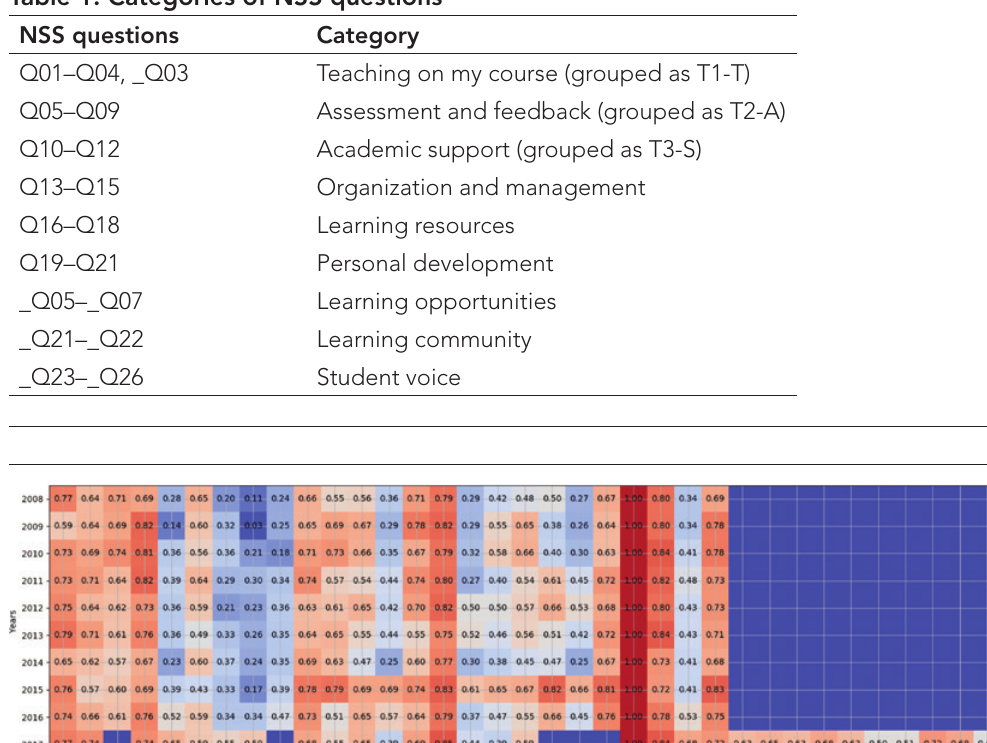
Table 1: Categories of NSS questions